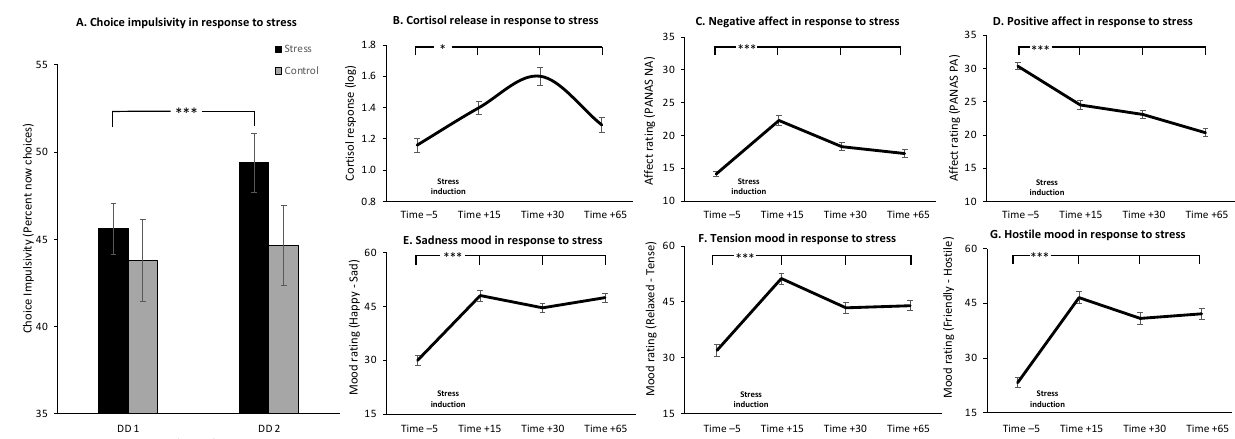
Figure 3. Main effects of stress. Changes in choice impulsivity ( A ), cortisol release ( B ), negative affect ( C ), positive affect ( D ), VAMS sadness scale ( E ), VAMS tension scale ( F ), VAMS hostility scale ( G ) throughout the experimental session. Across all measures, the acute stress procedure elicited the expected effects of increased impulsivity, increased cortisol release, increased negative mood and affect and decreased positive affect, at the group level. DD—delay discounting task; PANAS—positive and negative affect; VAMS—visual analogue mood scale. * p < 0.05, *** p < 0.001. Error bars represent standard error.